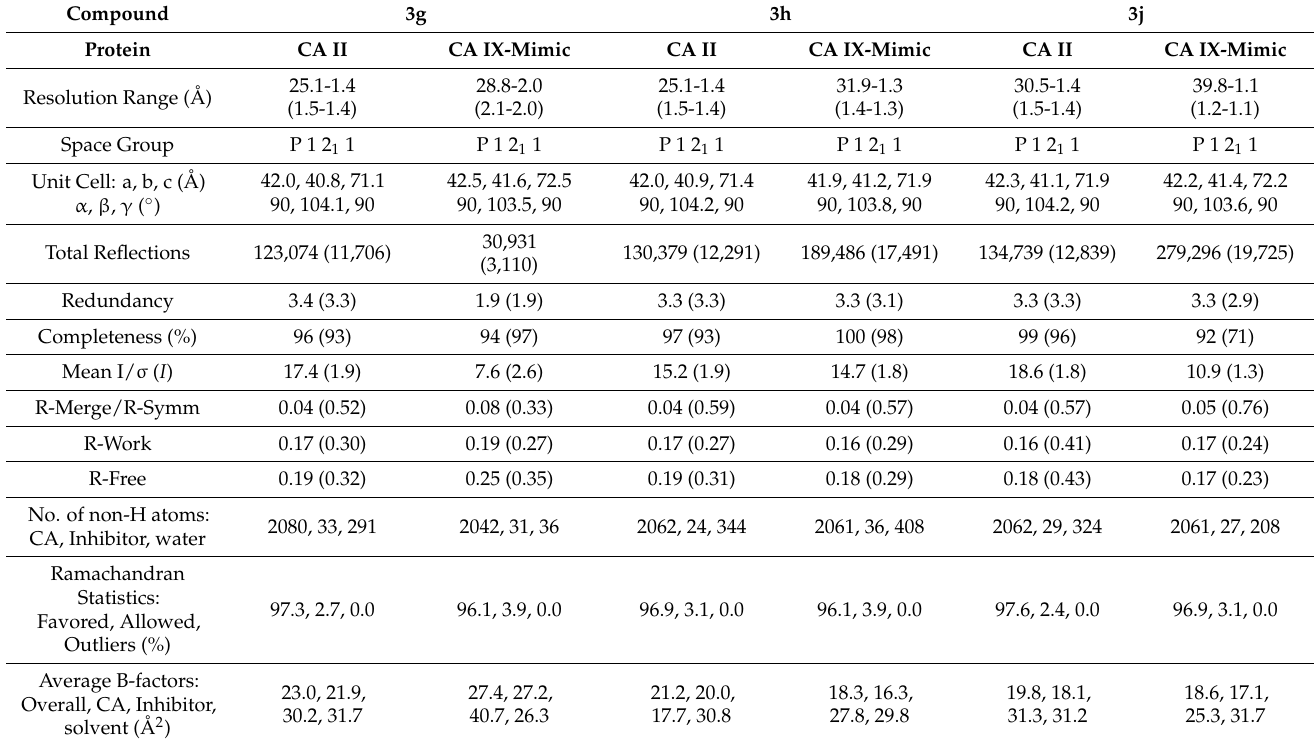
Table 2. X-ray diffraction data and refinement statistics for compounds 3g , 3h , and 3j in complex with CA II and CA IX-mimic. Statistics for the highest resolution shell are in